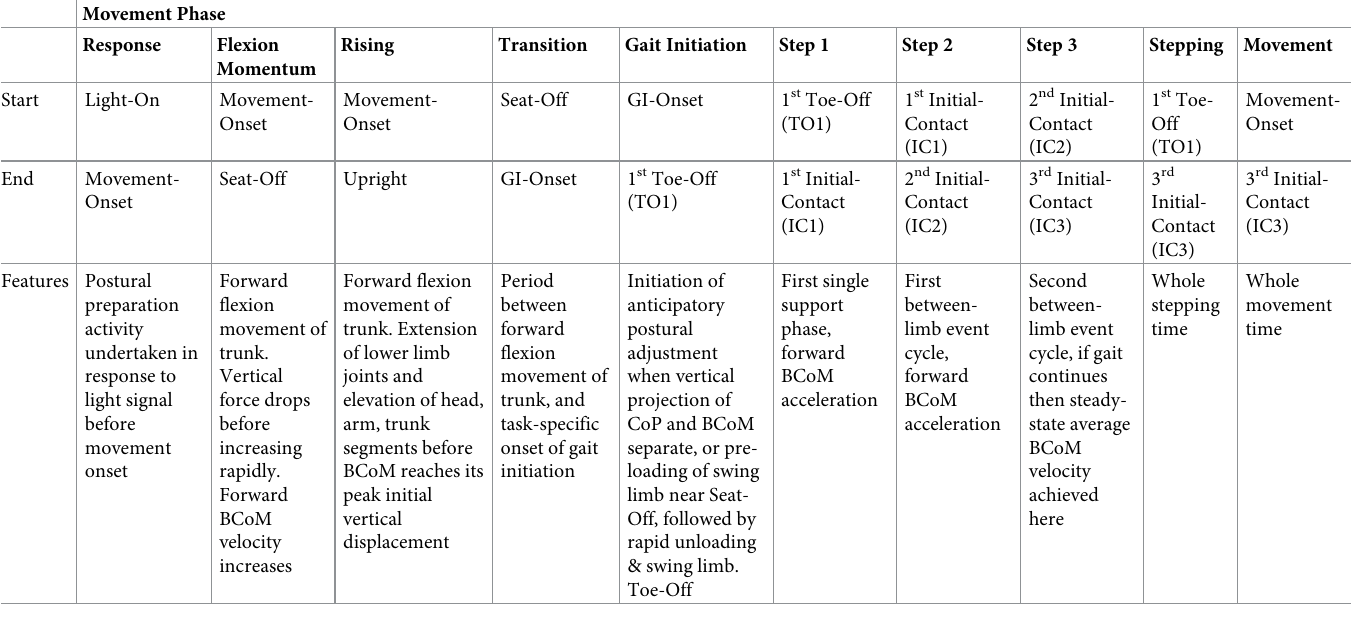
Table 2. Definition of movement phases during STW and